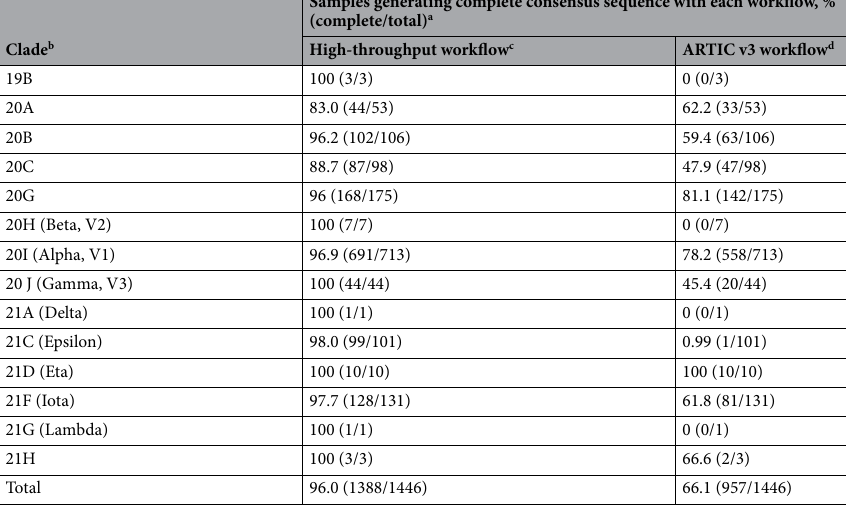
Table 3. Proportion of SARS-CoV-2 samples generating complete consensus sequence with the automated, high-throughput SARS-CoV-2 NGS workflow, by clade. a Complete consensus sequence as defined